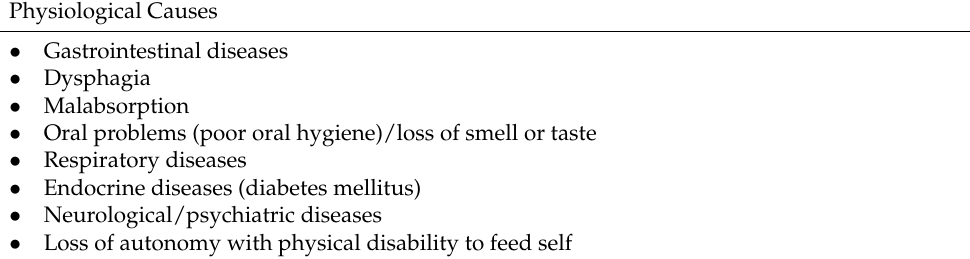
Table 1. Causes of malnutrition. Physiological